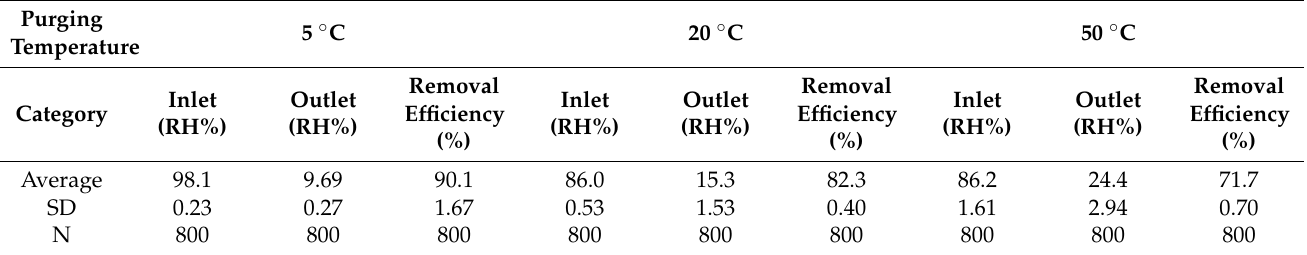
Table 5. Effect of KPASS–Odor purging temperature on outlet